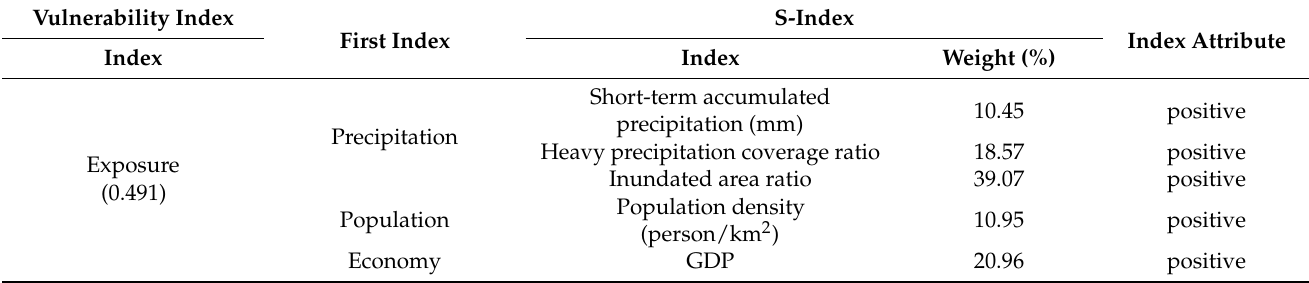
Table 2. Flood vulnerability evaluation index system and weight